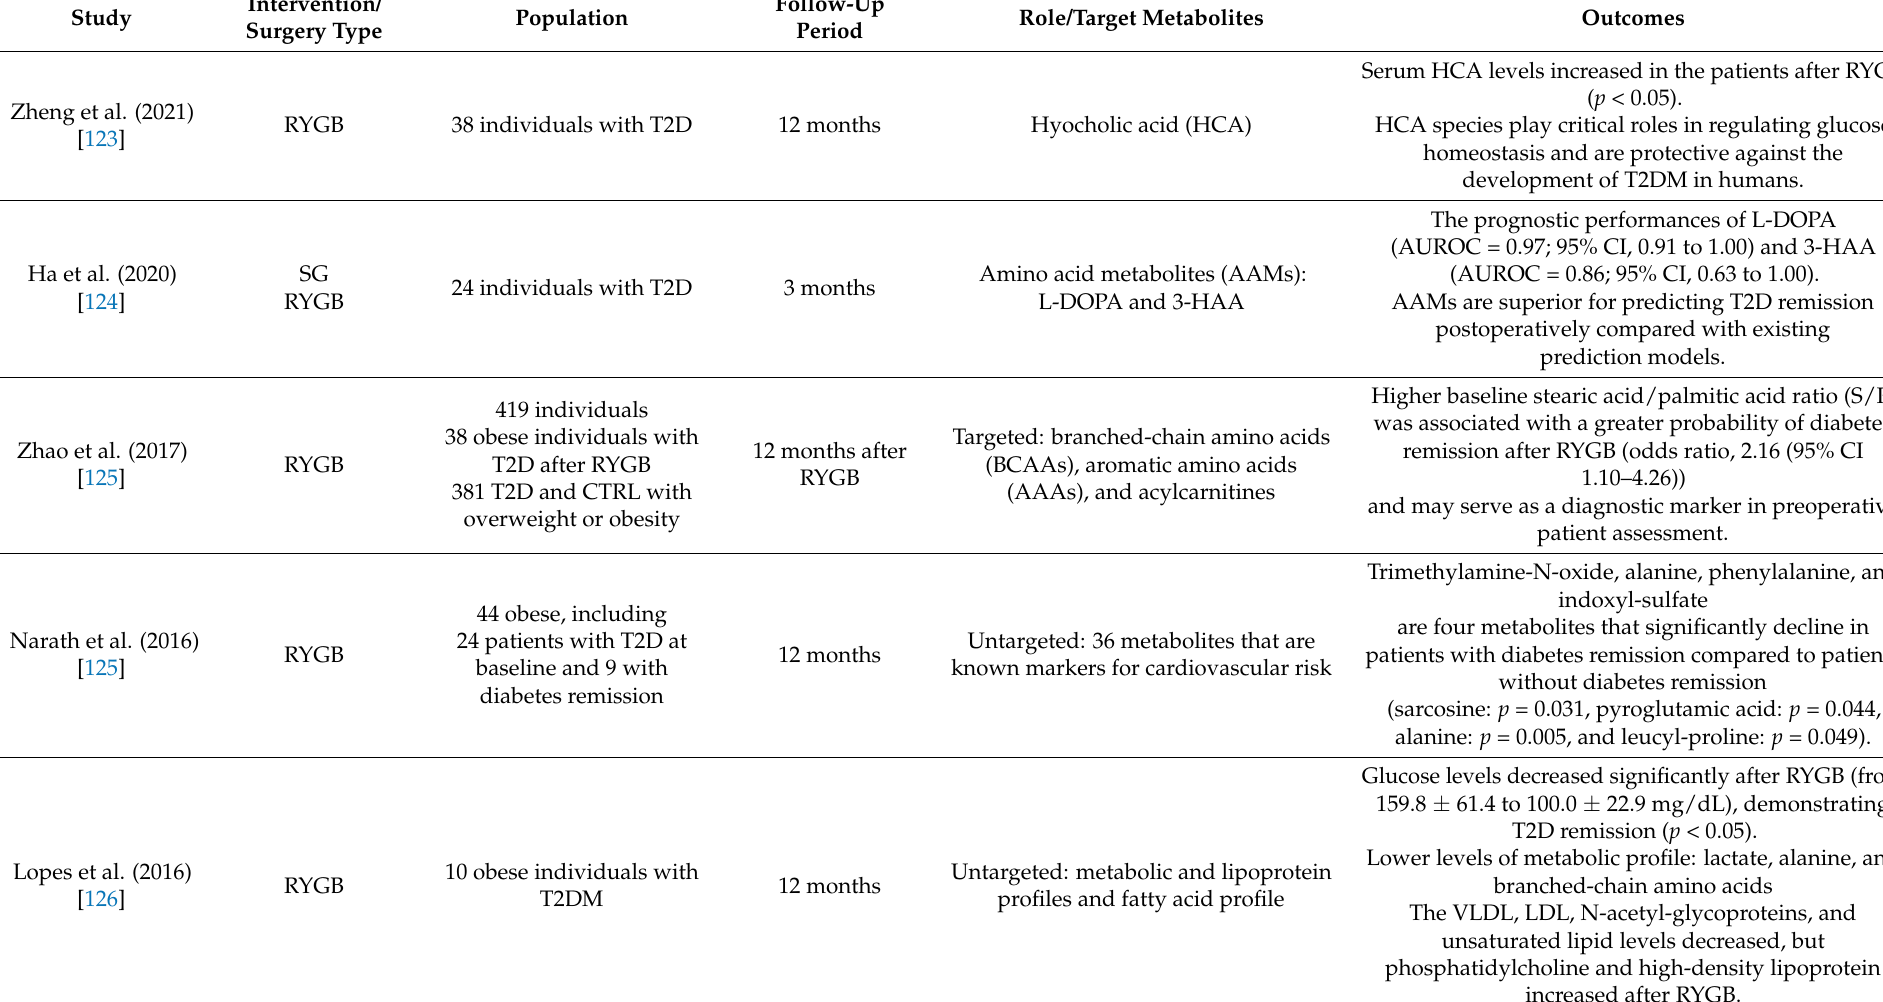
Table 3. Metabolomic profiles of metabolic